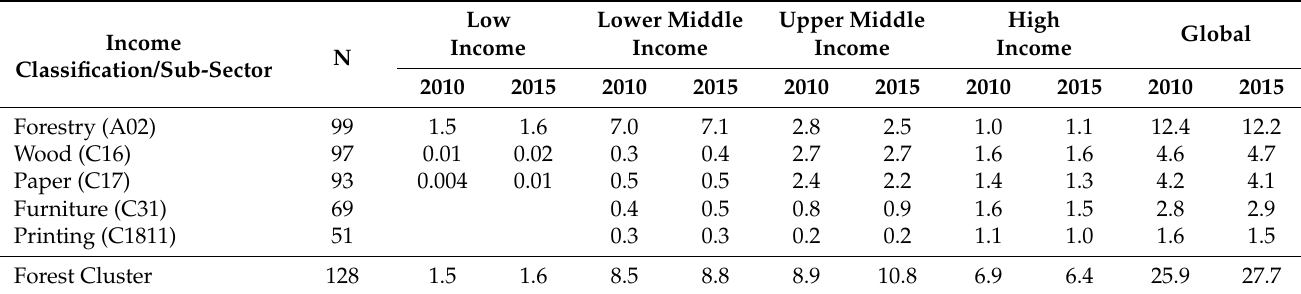
Table 3. Distribution of visible forest-based employment (million-person FTE), by income classification and sub-sector in 2010 and